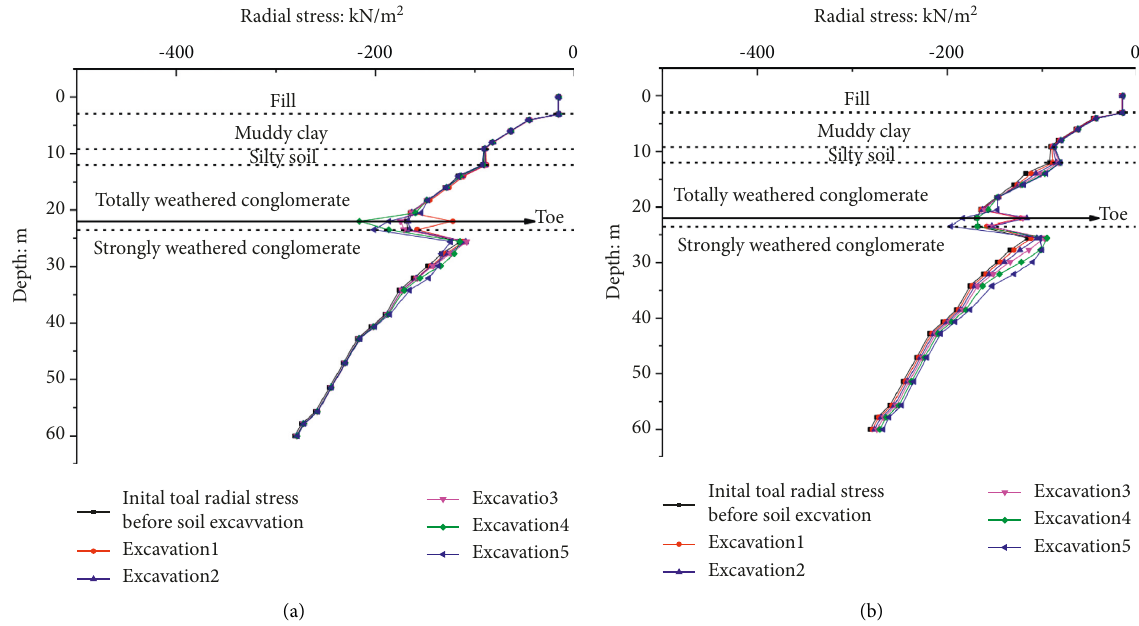
Figure 19: Radial stress distribution behind the wall with a depth at the center of Gutter 7 after soil excavation:effect of construction method. (a) Direct practice. (b) Inverse